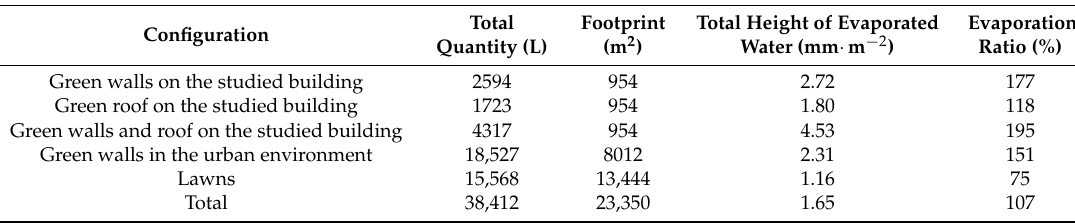
Table 2. Quantities of water evaporated by the various surfaces relative to both their ground coverage and